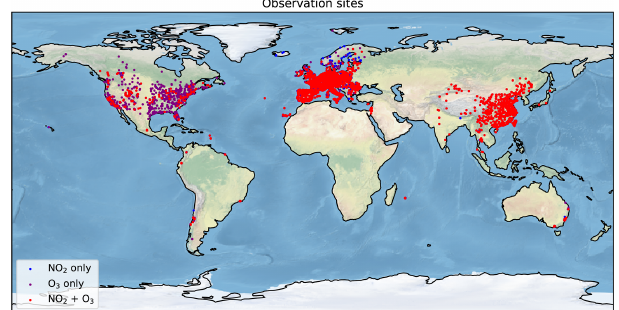
Figure 1. Location of the 5756 observation sites included in the analysis. Red points indicate sites with both NO 2 and O 3 observa- tions (3485 in total), purple points show locations with O 3 obser- vations only (978 sites), and blue points show locations with NO 2 observations only (1293 sites). See the Appendix for detailed maps for North America, Europe, and